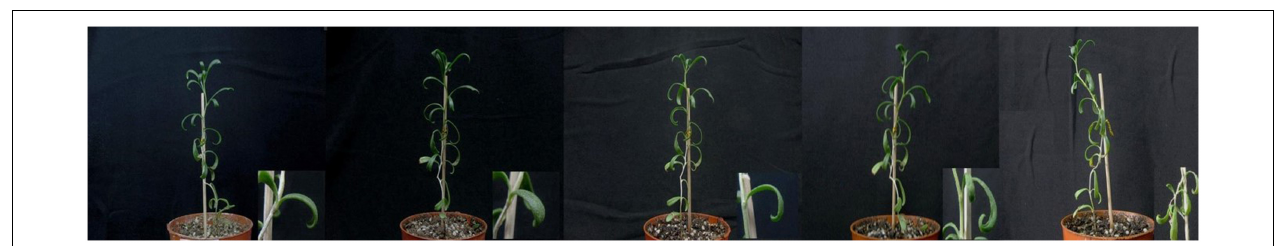
FIGURE 1 | Morphological changes in T. Nitraria seedlings after treatment with 500mM NaCl for 0, 1, 3, 5, and 7 days. The photographs show similar plants at the indicated time points. The